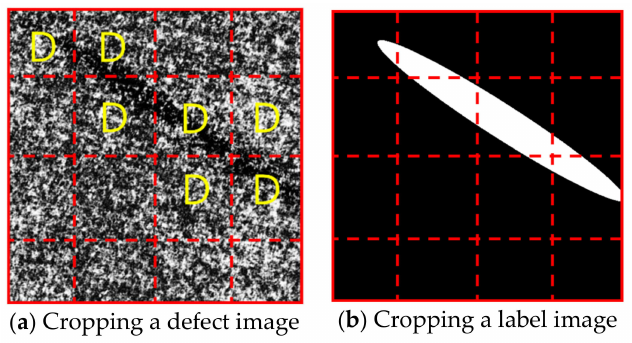
Figure 5. Example of defect image